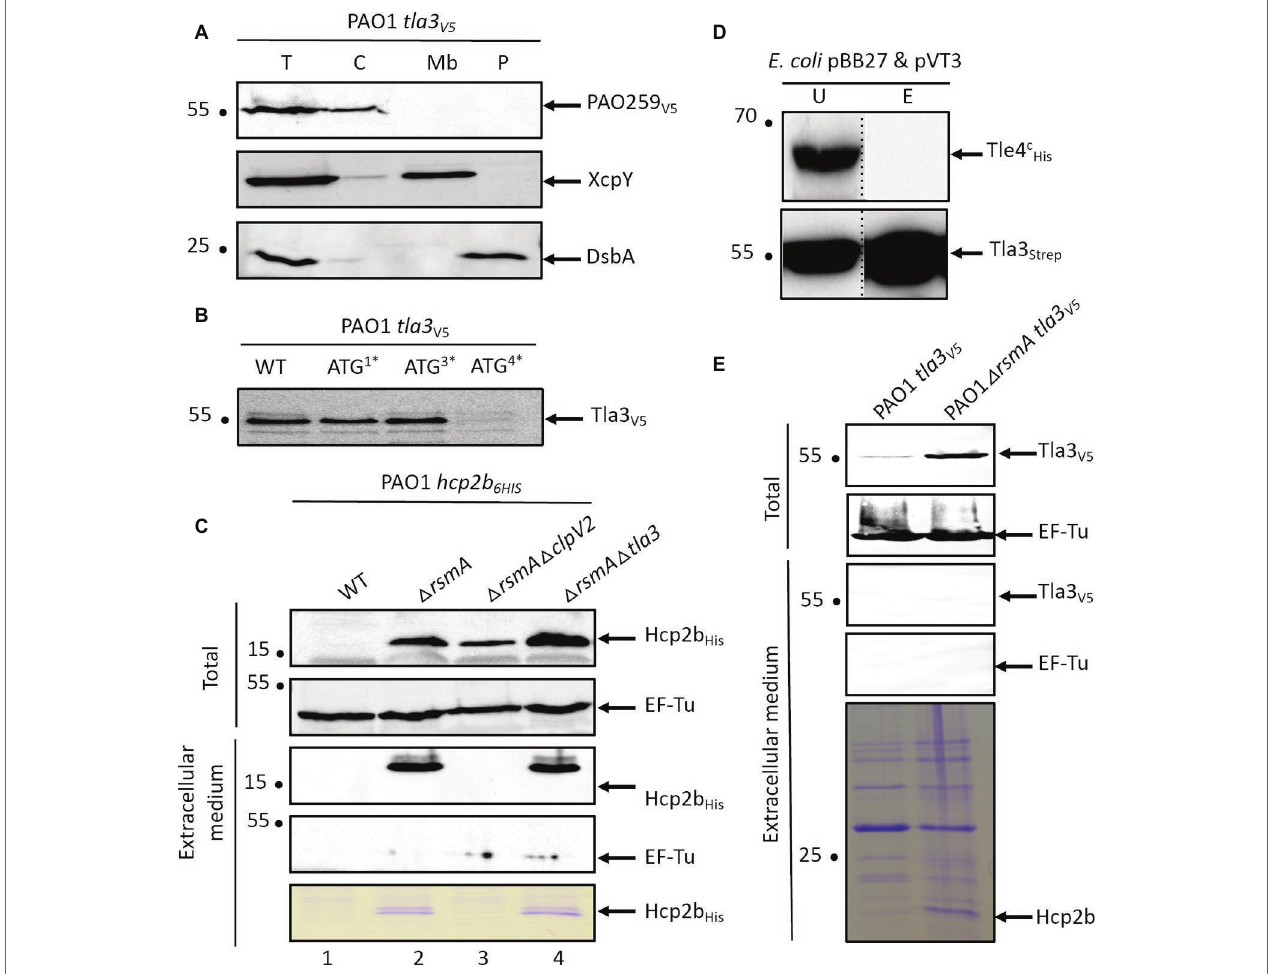
FIGURE 5 | (A) Tla3(PA0259) is a cytoplasmic protein of P. aeruginosa . Cells of P. aeruginosa PAO1 tla3 V5 were subjected to fractionation and immunoblotting using antibodies directed against the V5 tag, XcpY and DsbA. XcpY and DsbA were used as membrane and periplasmic controls, respectively. T, whole cell; C, cytoplasm; Mb, total membrane; P, periplasm. (B) The annotated ATG drives the initiation of translation of tla3 in P. aeruginosa . Immunodetection of Tla3 V5 with anti-V5 antibodies produced in a WT background or in strains in which one of the four predicted ATG in tla3 have been substituted in ATA. The number followed by a star indicates which ATG from Supplementary Figure S1 ATG 4 corresponds to the annotated ATG. (C) Tla3 is not required for Hcp2b secretion. Immunodetection of Hcp2b 6His with anti-His antibodies produced in a WT background (line 1) or in strains deleted for rsmA (lines 2–4) and clpV2 (line 3) or tla3 (line 4). The strains were grown at 25 ° C for 24 h and total bacteria were separated from extracellular medium. Anti-EF-Tu is used as a lysis control. The extracellular medium proteins were also stained with Coomassie-blue. (D) Tla3 does not interact with Tle4. Copurification assay on StrepTactin column of Tla3 c STREP with Tle4 His produced in E. coli BL21(DE3)pLysS from pBB27 and pVT3 respectively. Legend is as in Figure 4 . (E) Tla3 is not secreted. Immunodetection of Tla3 V5 with anti-HV5 antibodies produced in a WT background (line 1) or in strain deleted for rsmA (line 2). The strains were grown at 25 ° C for 24 h and total bacteria were separated from extracellular medium. Anti-EF-Tu is used as a lysis control. The extracellular medium proteins were also stained with Coomassie-blue. (A-E) The position of the proteins and the molecular mass markers (in kDa) are